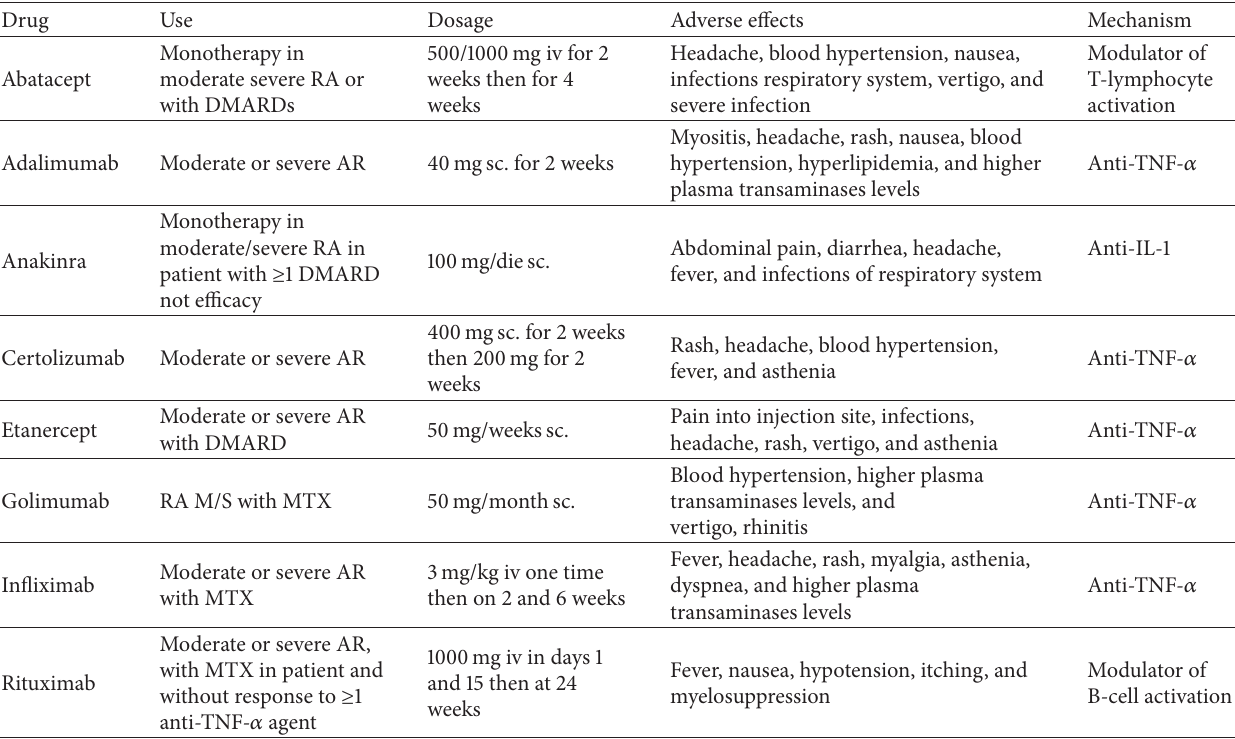
Table 2: Disease-modifying antirheumatic